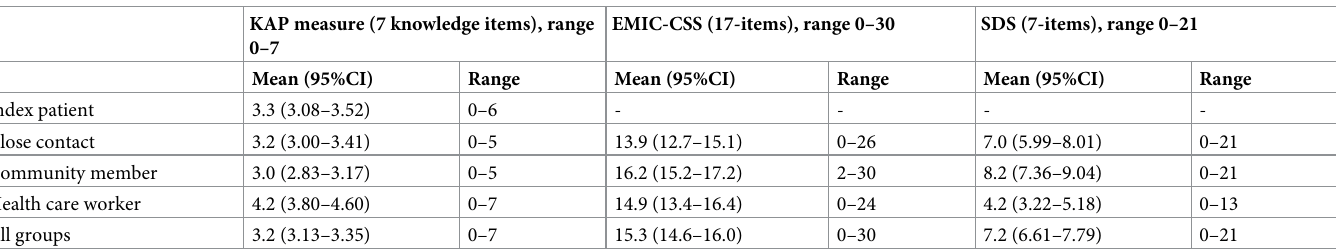
Table 4. Mean total scores per participants group. A high score on the KAP measure reflects higher knowledge, whereas high EMIC-CSS and SDS scores reflect higher levels of stigma and desired social distance respectively.